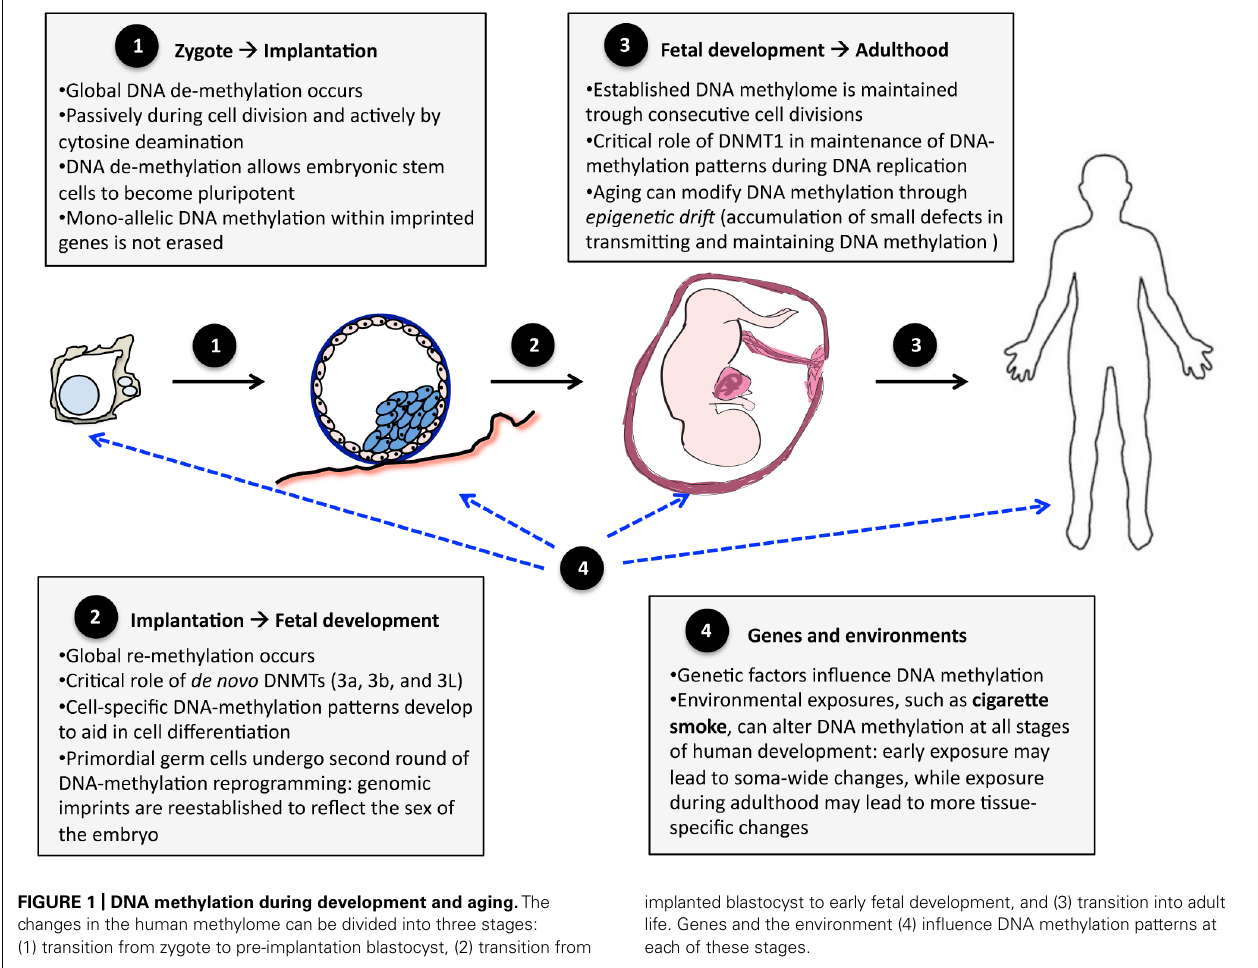
FIGURE 1 | DNA methylation during development and aging. The changes in the human methylome can be divided into three stages: (1) transition from zygote to pre-implantation blastocyst, (2) transition from